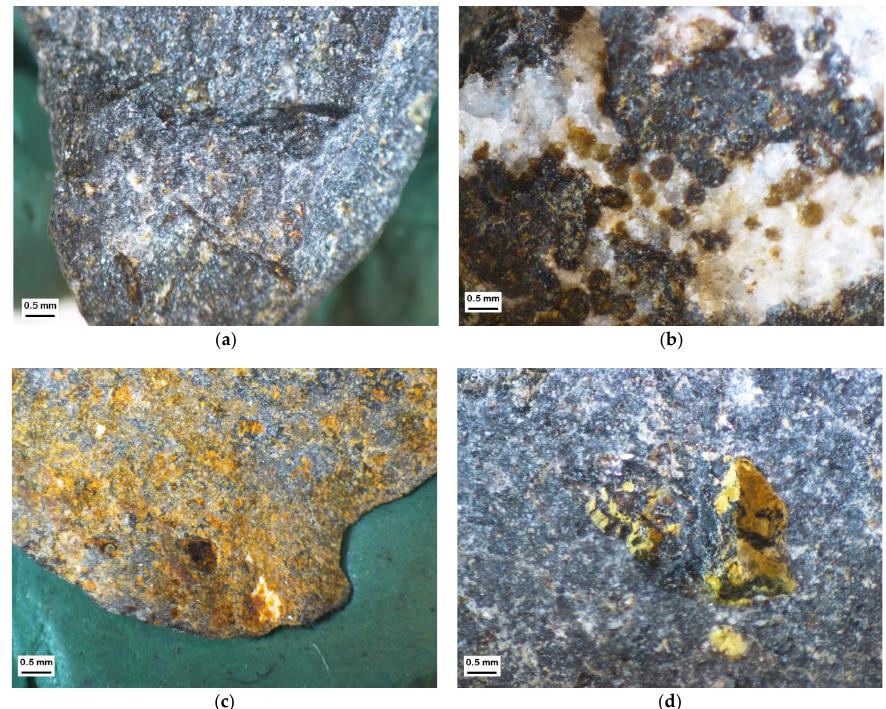
Figure A2. Characteristics of cracks in samples after crushing in jaw crusher (feed—original sample): ( a ) Basalt aggregate 2, non-flaky grains, +8 mm; ( b ) Basalt aggregate 2, non-flaky grains, +16